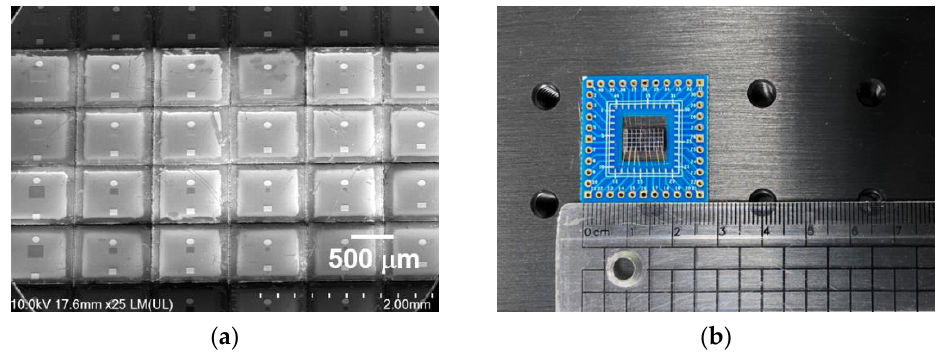
Figure 1. ( a ) A SEM image of blue micro-LEDs and red QD micro-LEDs from size 100 × 100, 50 × 50, 25 × 25, and 10 × 10 μm 2 ; ( b ) the image of a micro-LED chip wire boned on a 3 × 3 cm 2 PCB.